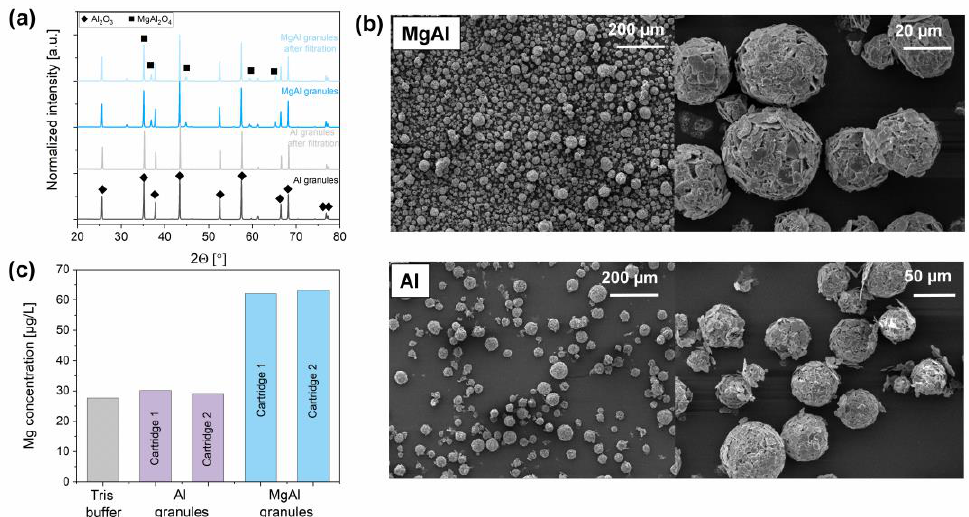
Figure 4. Characterization of the granules after filtration. ( a ) X-ray diffractograms, ( b ) electron micrographs, and ( c ) associated magnesium concentrations detected in permeate, as determined by ICP-OES.